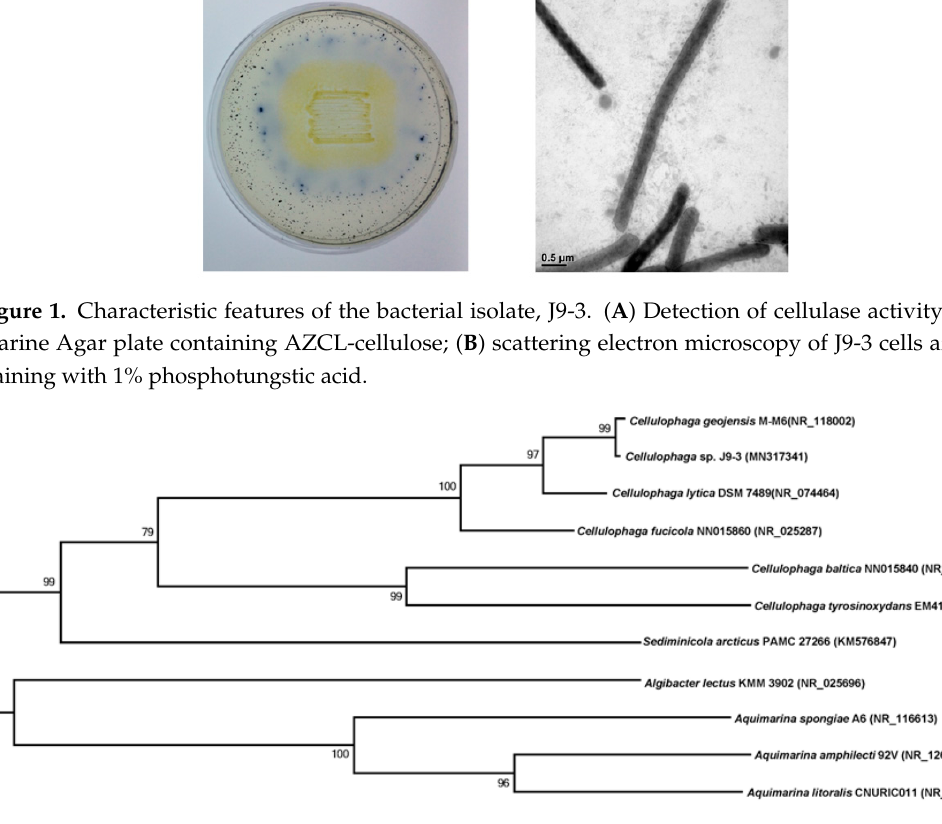
Figure 1. Characteristic features of the bacterial isolate, J9-3. ( A ) Detection of cellulase activity on Marine Agar plate containing AZCL-cellulose; ( B ) scattering electron microscopy of J9-3 cells after staining with 1% phosphotungstic acid.